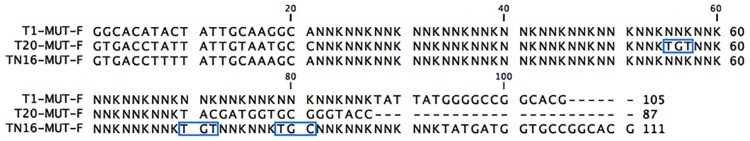
Mutagenic oligonucleotides used to diversify the CDR3.The oligonucleotides T1-MUT-F, T20-MUT-F and TN16-MUT-F were used with framework T1, T20 and TN16 respectively. With the exception of the cysteine-encoding codons (enclosed in blue), all of the other codons at CDR3 encode NNK. The length of the CDR3 of each framework was respected.